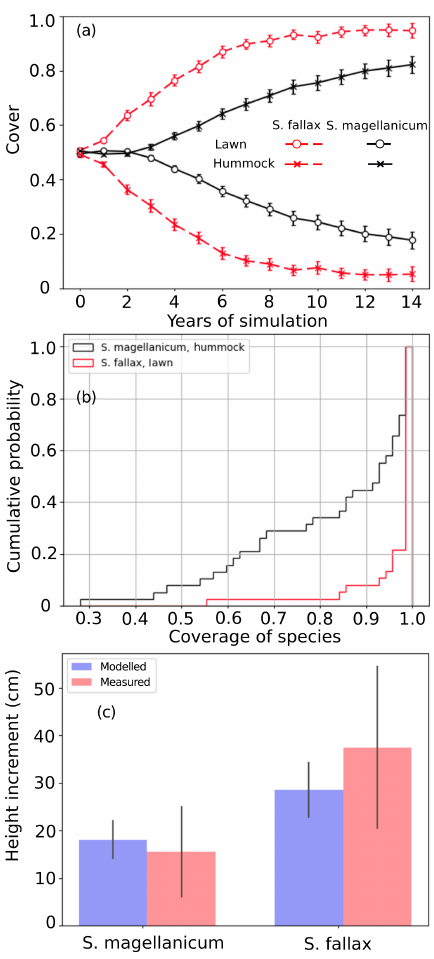
Figure 2. Testing the ability of PMS to predict the habitat prefer- ence of Sphagnum magellanicum and S. fallax (Test 1). The hum- mock and lawn habitats were differentiated by the water table depth, the surface energy balances, and the capitulum water potential in the model simulations. At the beginning of the simulation, the cover of the two species was set to be equal and it was allowed to develop with time. (a) The annual development of the relative cover (mean and standard error) of the two species in hummock and lawn habitats, (b) the cumulative probability distribution of the cover of the two species at the end of the 15-year period based on 40 Monte Carlo simulations, and (c) the simulated and measured means of the annual vertical growth of Sphagnum surfaces in their natural habitats (hummock and